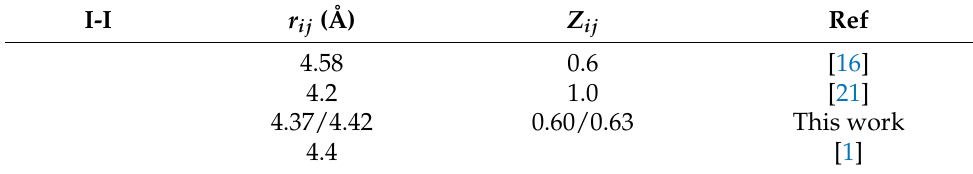
Figure 4. ( a ) PDF (I-I) with Z I,I = | 0.60 | (black line), Z I.I = | 0.63 | (red line), and Z I,I = | 1.00 | (blue line). ( b ) Integrated PDF ( N I-I ). Temperature 300 K. Table 4. Comparison of I-I PDF. The temperature at 300